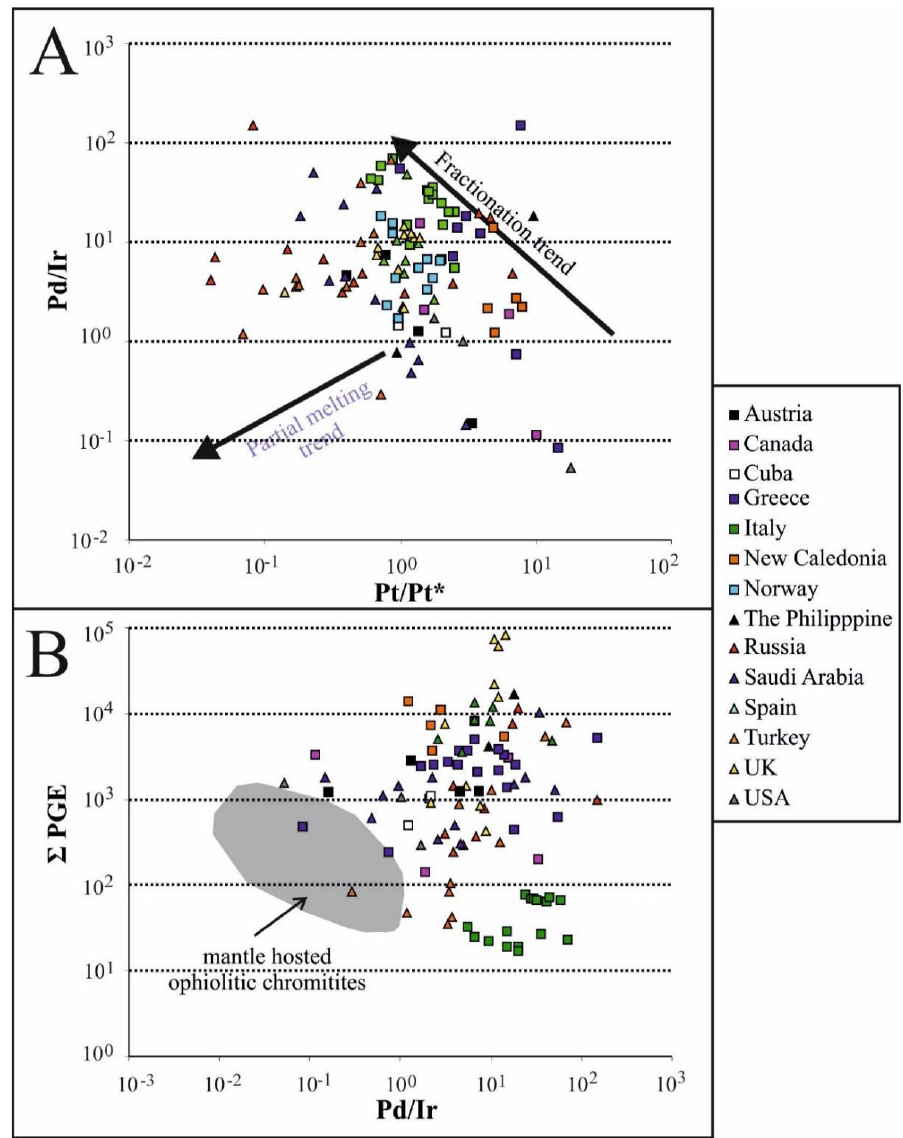
Figure 4. Binary diagrams for PPGE-rich ophiolitic chromitites. ( A ) Plot of the ratio Pd/Ir versus Pt/Pt* (calculated after Garuti et al. [62]), ( B ) PGE contents versus Pd/Ir ratio and comparison with the IPGE-rich ophiolitic chromitite, redrawn after Leblanc [7].